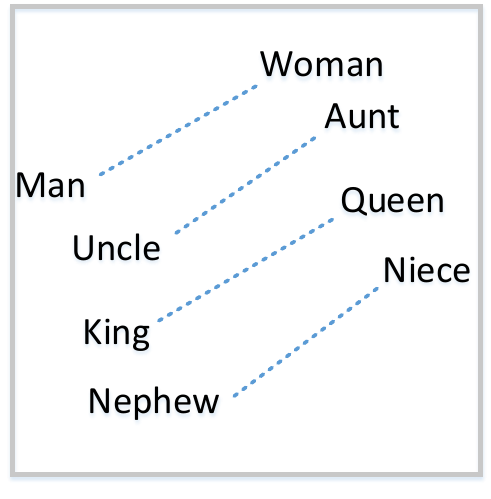
Figure 3. GloVe: Global Vectors for Word